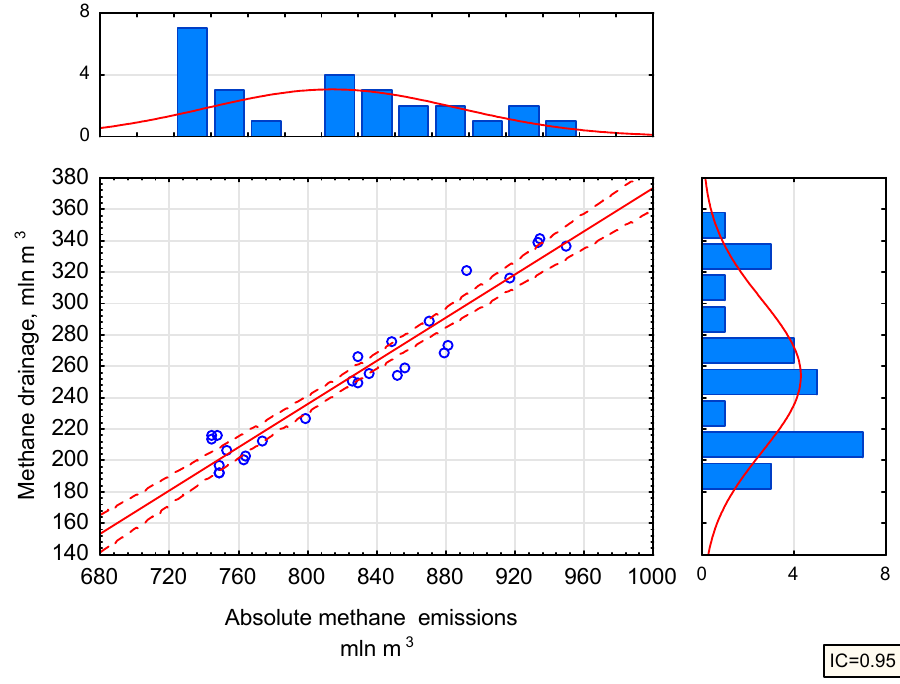
Figure 6. Relationship between absolute methane emissions and methane drainage in hard coal mines in Poland.